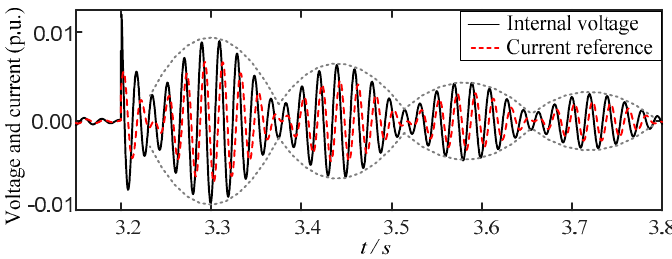
Figure 6. The internal voltage and current reference waves in time-domain simulation after a small-signal disturbance.